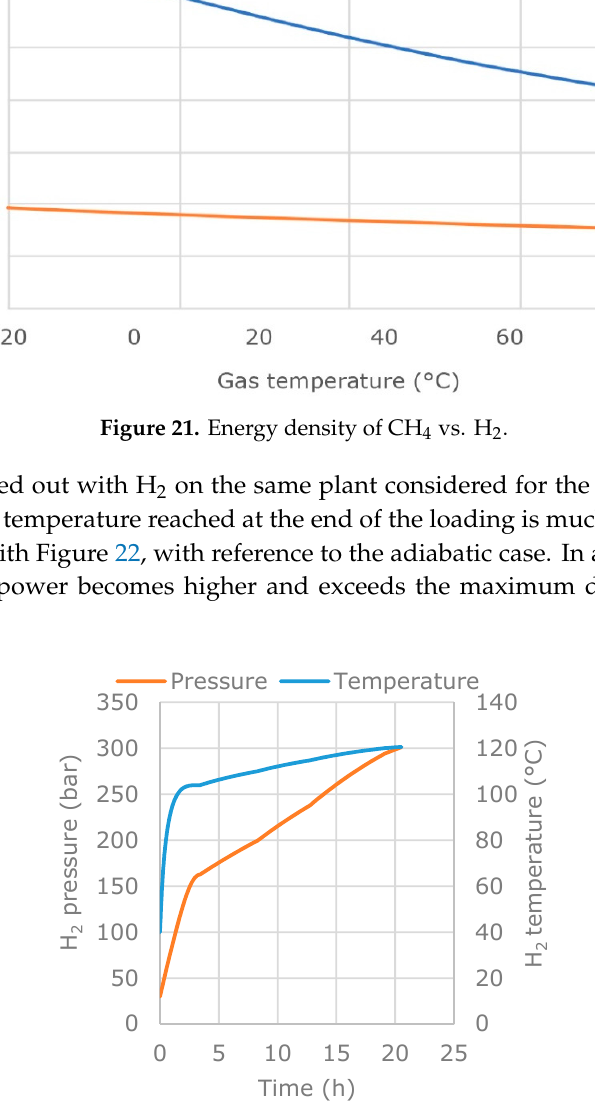
Figure 22. Pressure vessels conditions (H 2 Figure 22. Press ure vessels conditions (H 2 loading).